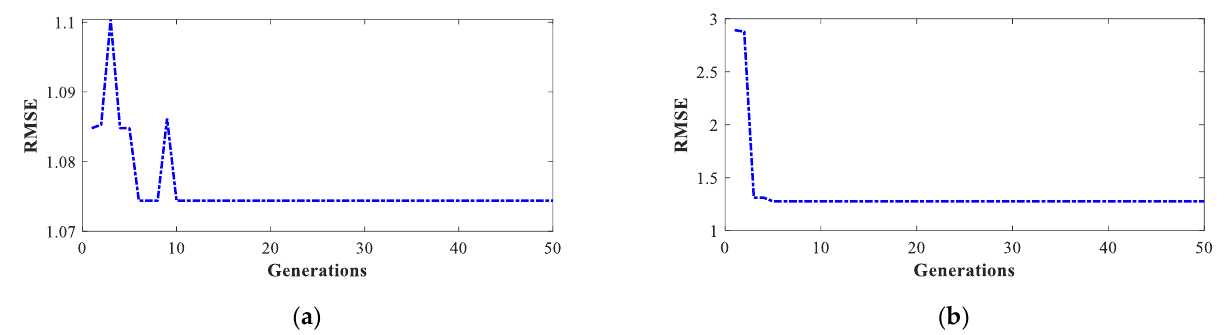
Figure 5. Evolution of the RMSE value through the generations for the second transmission shift tests: ( a ) test 2 (test with the lowest RMSE value) and ( b ) test 1 (test with the highest RMSE value). Table 4. Variables that best minimize the RMSE for the third transmission shift. For this case, the lowest RMSE value was obtained in test 5 and the highest value was obtained in test 1. The evolution of these values through the GA generations is shown in Figure 6.